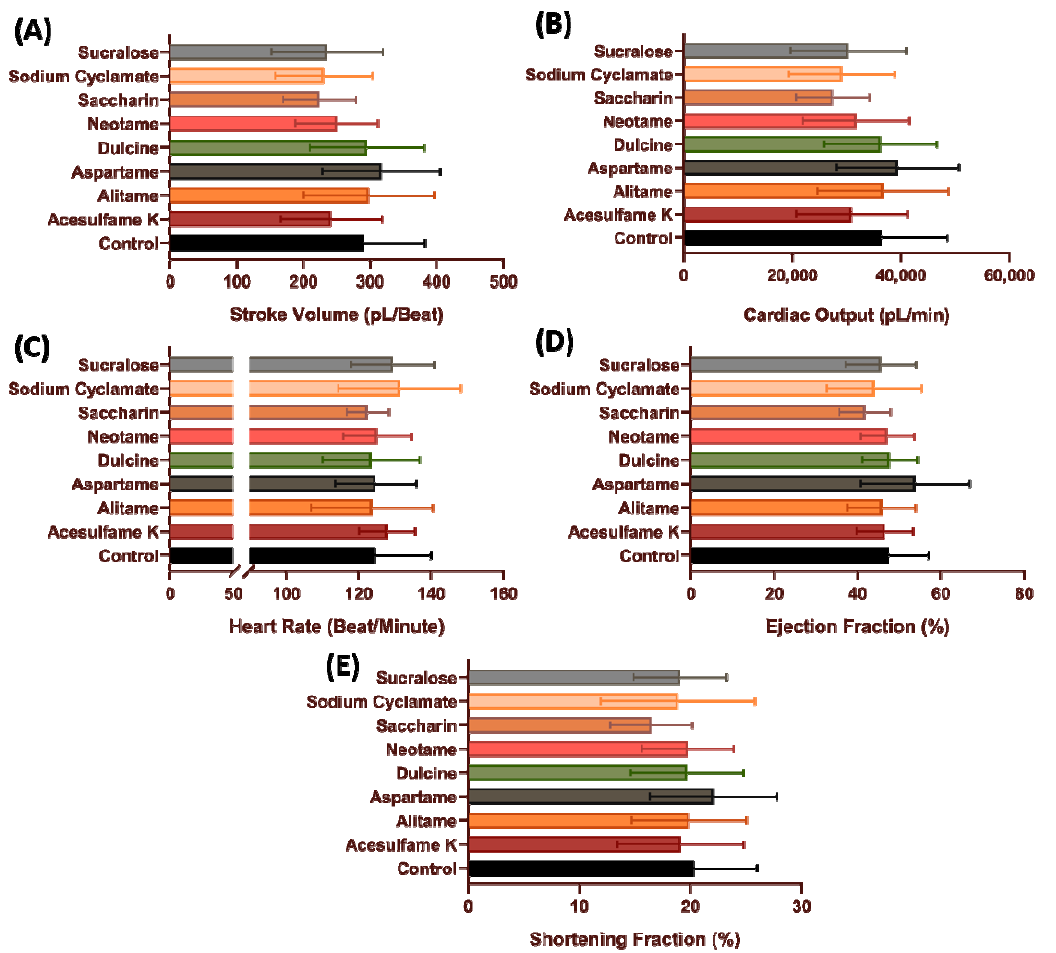
Figure 6. Cardiac performance endpoints for zebrafish after sub-chronic exposure to eight different artificial sweeteners at highest environmental relevant concentration (100 ppb). Cardiac physiology endpoints like ( A ) Stroke volume, ( B ) Cardiac output, ( C ) Heart rate, ( D ) Ejection fraction and ( E ) Shortening fraction were measured and compared. Data were presented as mean ± SD and statistical significances were tested by Ordinary One-Way ANOVA test followed by Fisher’s LSD test as post-hoc multiple comparison test ( n = 15). (* p < 0.05).